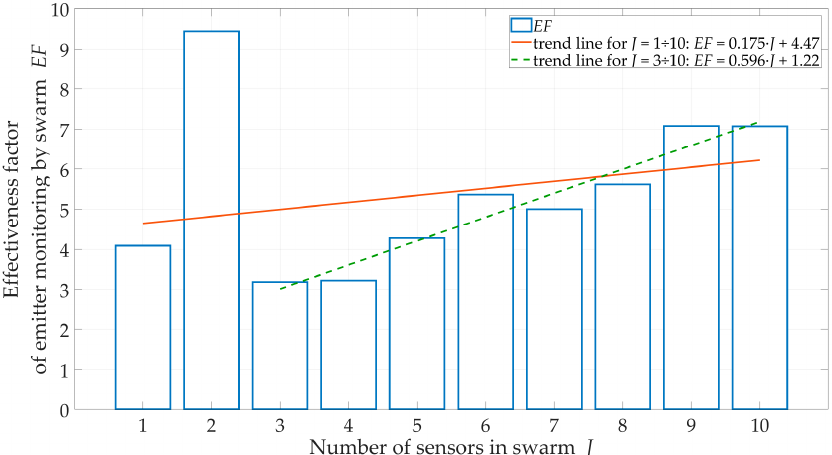
Figure 10. EF versus number of sensors in swarm for suburban area.